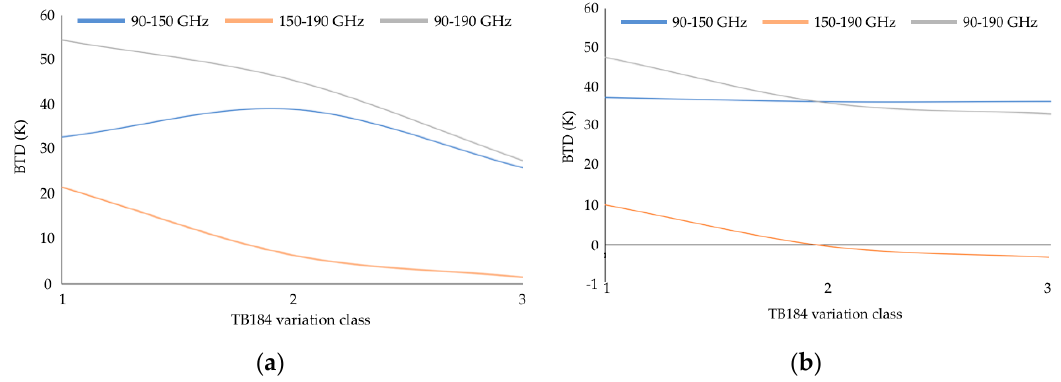
Figure 6. Brightness temperature differences (BTD) fitting the three 𝑇𝐵 (cid:2869)(cid:2876)(cid:2872)(cid:3049)(cid:3028)(cid:3045) classes for hail diameters 2 < d < 10 cm ( a ) and d > 10 cm ( b ). Note that the difference (BT150–BT190) shows high sensitivity in capturing hail features with changing diameters.